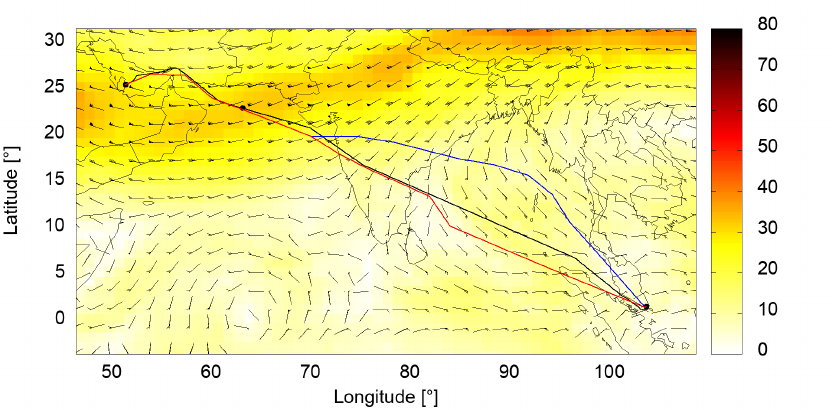
Figure 9. Three different lateral routes for A330 flight QTR946 from OTHH to WSSS. The route was changed from t i = 11:00 a.m. Black: original route with arrival time at 3:55 p.m. and fuel burn 37,182 kg. Blue: first alternative arriving at 4:18 p.m. with 37,976 kg fuel burn. Red: second alternative arriving at 3:14 p.m. with 36,154 kg fuel burn. Without any speed adjustments, arrival times could be adjusted by 50 min with differences in fuel burn of δ m f = 1822